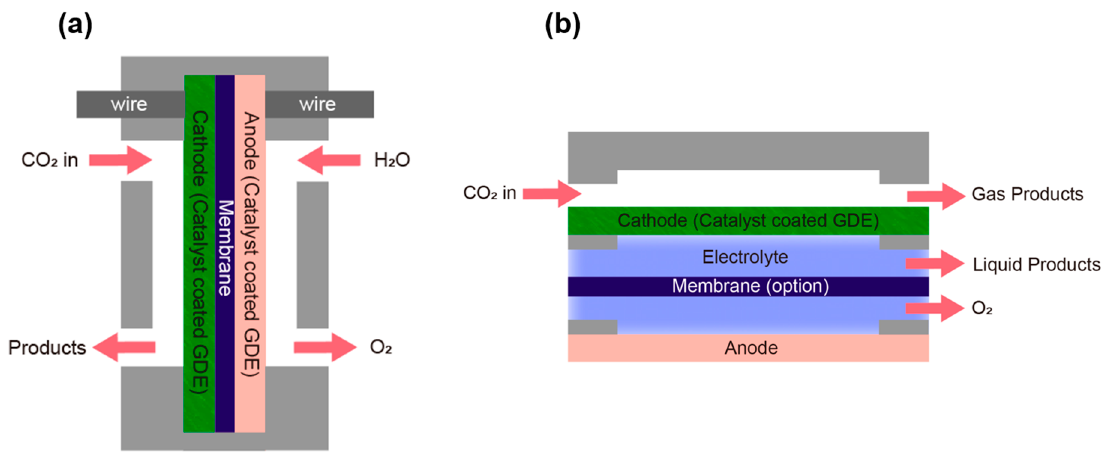
Figure 7. The cell configuration comparison for gas-phase CO 2 reduction reaction: ( a ) membrane electrode assembly (MEA) and ( b ) microfluidic type.